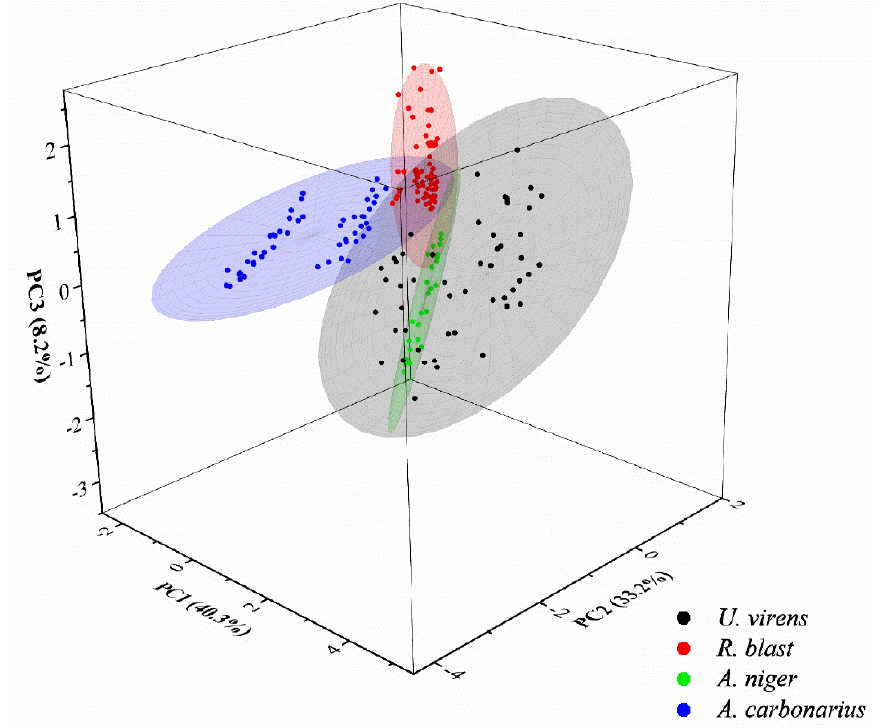
Figure 9. Top 3 PCA distribution results.